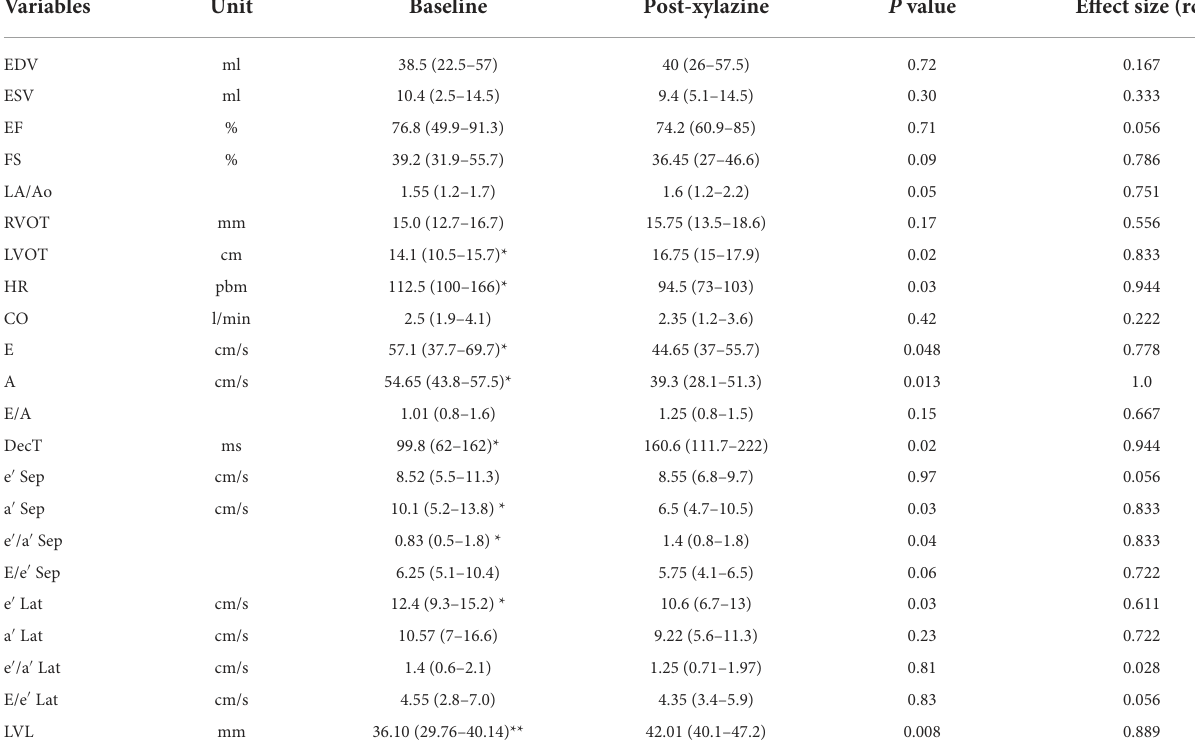
TABLE 1 Conventional echocardiographic measurements before and after xylazine administration in male